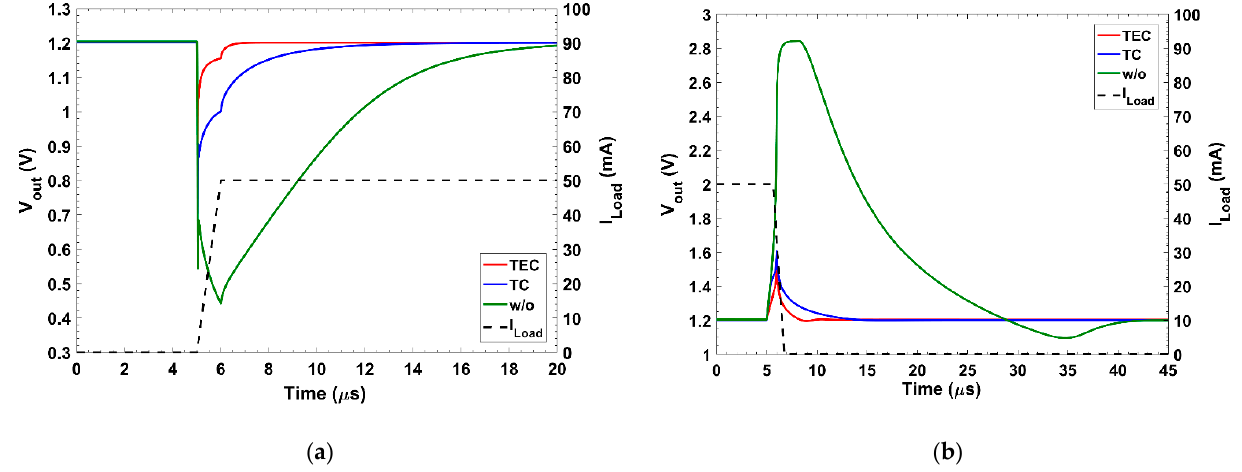
Figure 15. Load transient behavior: with and w/o the TC and TEC transient circuits for V BAT 3.3 V: ( a ) undershoot and ( b ) overshoot.